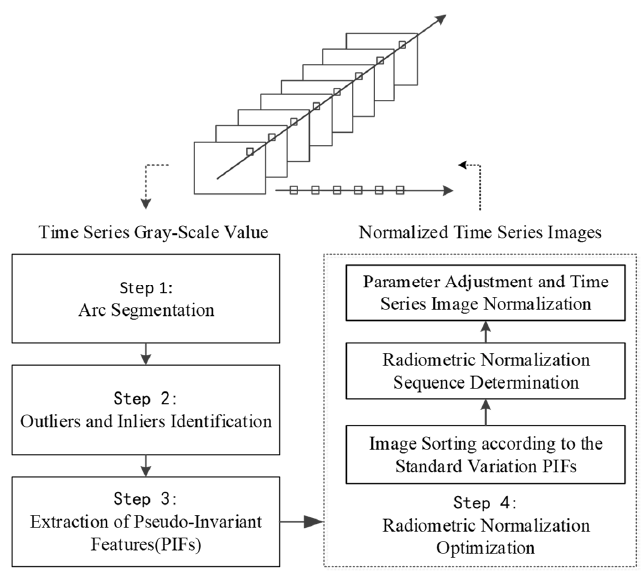
Figure 5. Flowchart of a long time-series radiometric normalization method for Landsat images proposed in this paper.